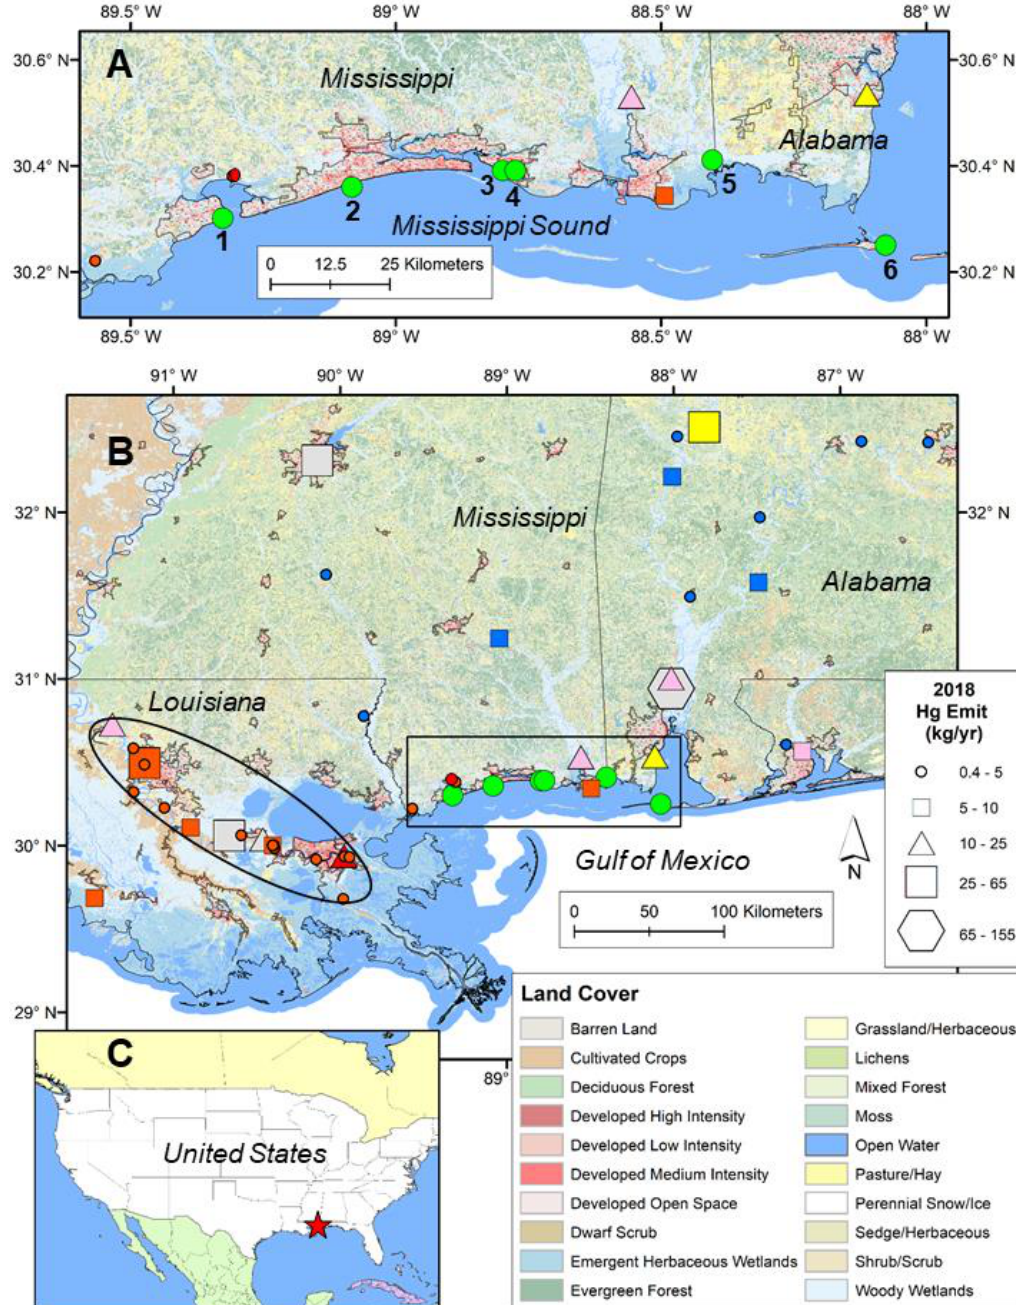
Figure 1. Maps of the study site. ( A ) = close up showing the six sampling locations as green circles (1 = Bay St. Louis; 2 = Gulfport; 3 = Gulf Coast Research Laboratory (GCRL) Main; 4 = GCRL Cedar Point; 5 = Grand Bay National Estuarine Research Reserve (NERR); 6 = Dauphin Island). ( B ) = a regional view with the close-up domain indicated in the box. ( C ) = a general location map showing the study site with star. The Hg air emission point sources are based on the most recent toxic release inventory data (2018) [29], where the size and shape of the emissions symbols indicate the amount of emissions (kg / year) and the color of the symbol indicates the source category: refineries and chemicals (red); electric power generation (pink); metals (gray); paper (blue); cement (yellow). Land cover categories are based on the 2011 National Land Cover Database [30]. The New Orleans and Baton Rouge area in Louisiana (shown with an oval) has gaseous elemental mercury (GEM) emission sources from multiple industries.